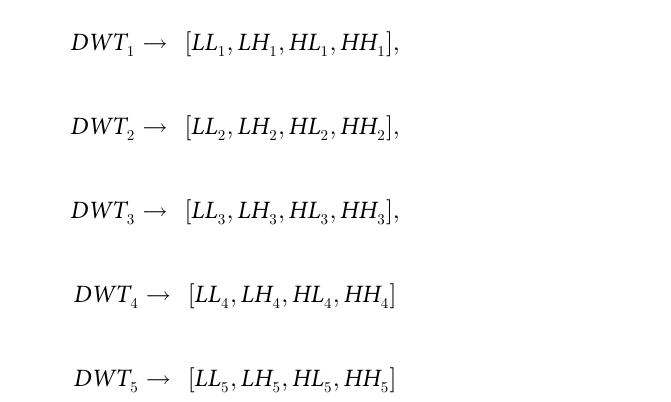
sub-band values with 4